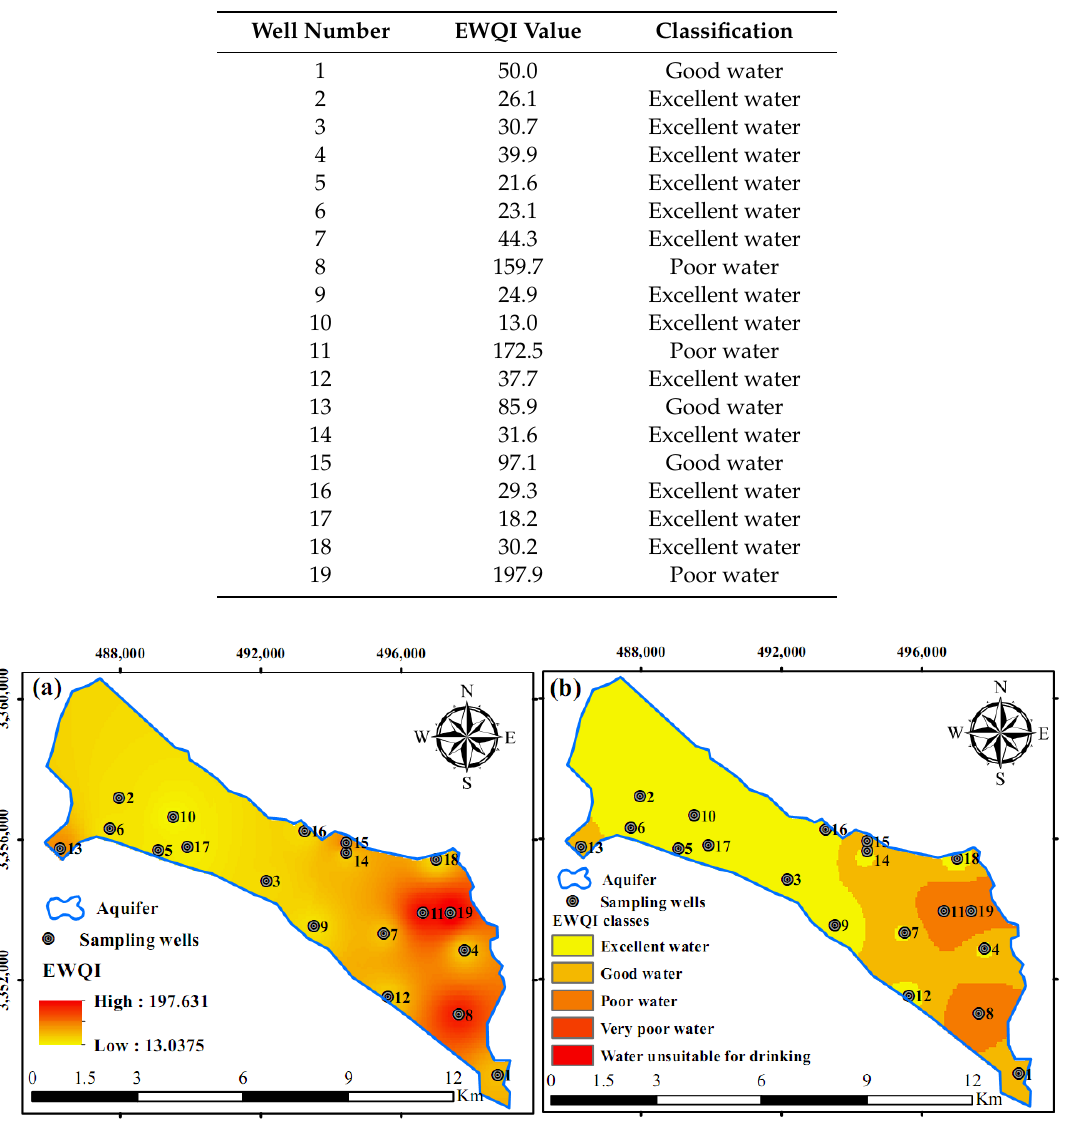
Table 4. EWQI for groundwater in the study area.